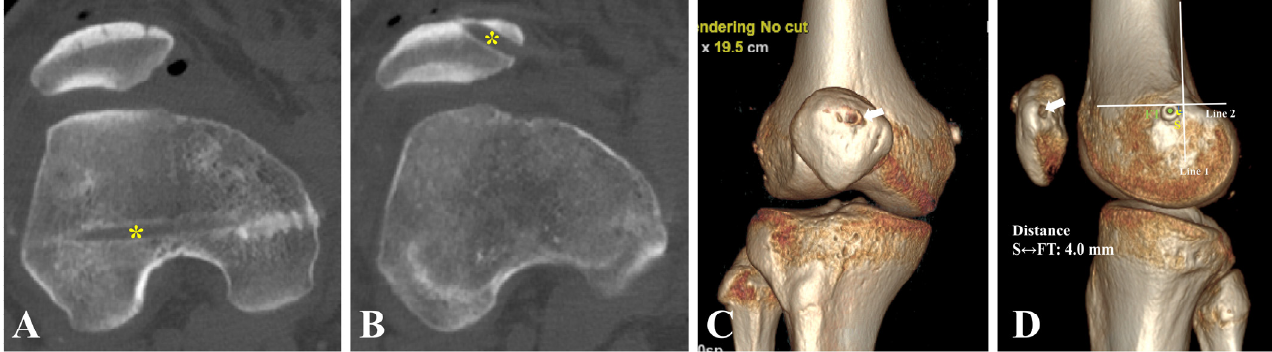
Figure 8. Postoperative imaging evaluation. Right knee. ( A , B ) Axial CT showing the femoral tunnel and the patellar tunnel (yellow asterisks). ( C ) Anterior view of three-dimensional CT reconstruction showing the patellar tunnel (white arrow). ( D ) Medial view of three-dimensional CT reconstruction. The patellar tunnel (white arrow) is located at the upper-third point of the medial patellar margin. The center of the arthroscopically localized femoral tunnel (green spot) lies 4.0 mm anterior to Schöttle’s point (yellow spot), which can be defined as precise tunnel placement according to prior studies [7,12,24]. CT, computed tomography. FT, femoral tunnel. S, Schöttle’s point.